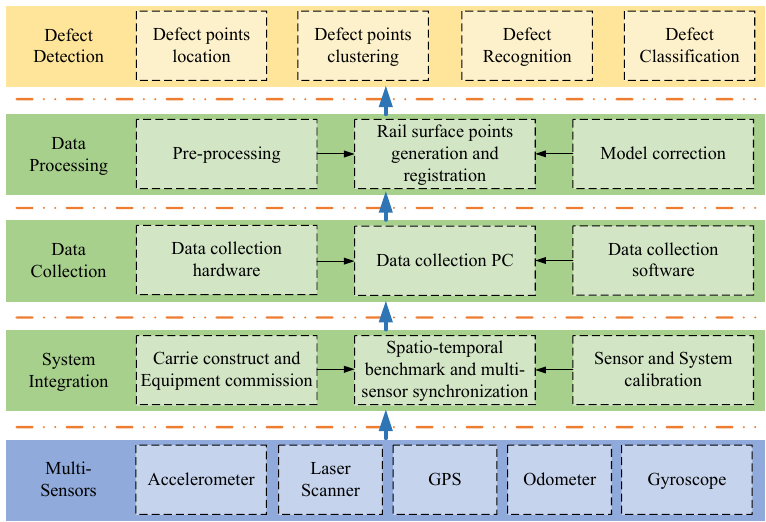
Figure 2. System architecture.